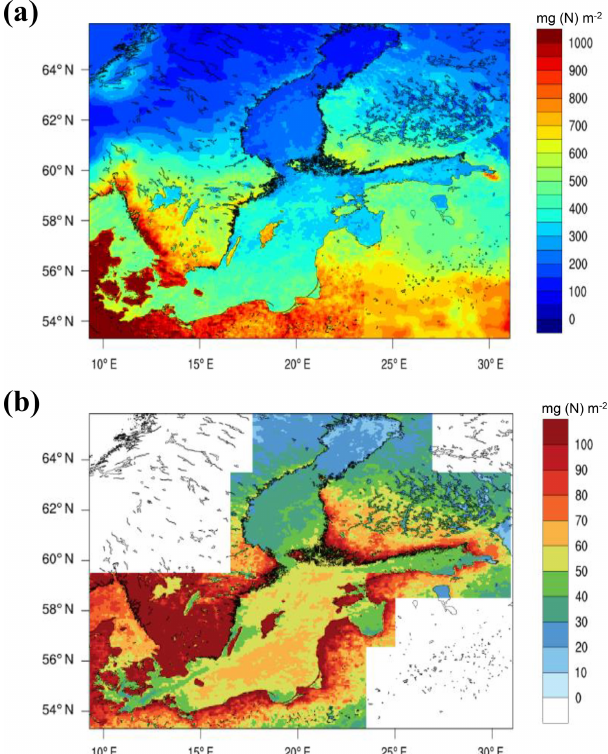
Figure 4. Present-day (2012) accumulated total deposition of nitro- gen (in mg ( N ) m − 2 ) in the Baltic Sea region from CMAQ model results: (a) annual deposition and (b) annual ship-related deposi- tion. Ship contribution is only shown for the high-resolution area.